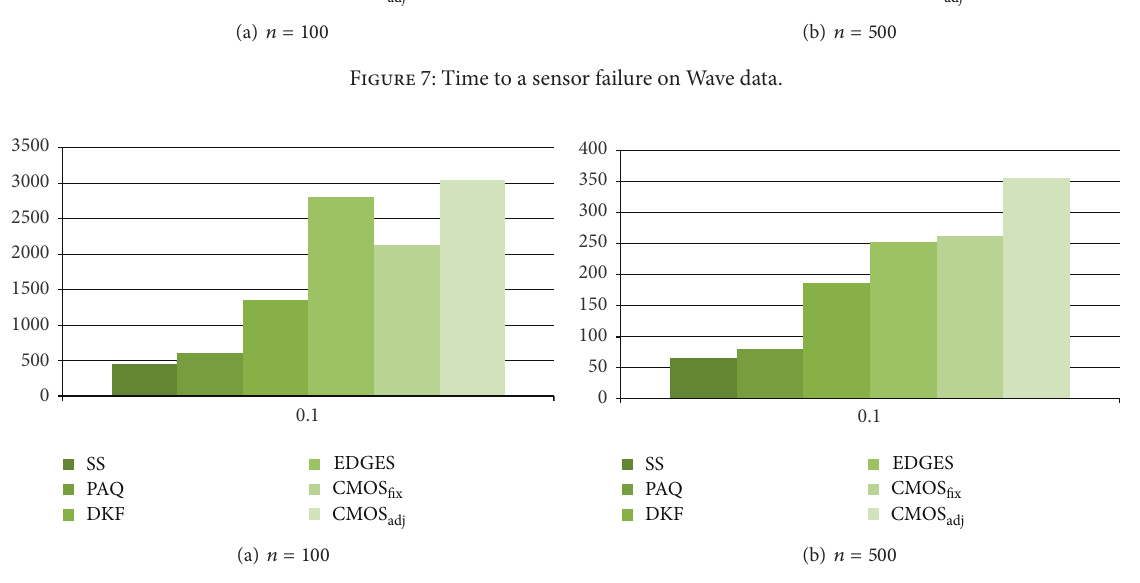
Figure 8: Time to a sensor failure on EnergyDisperse